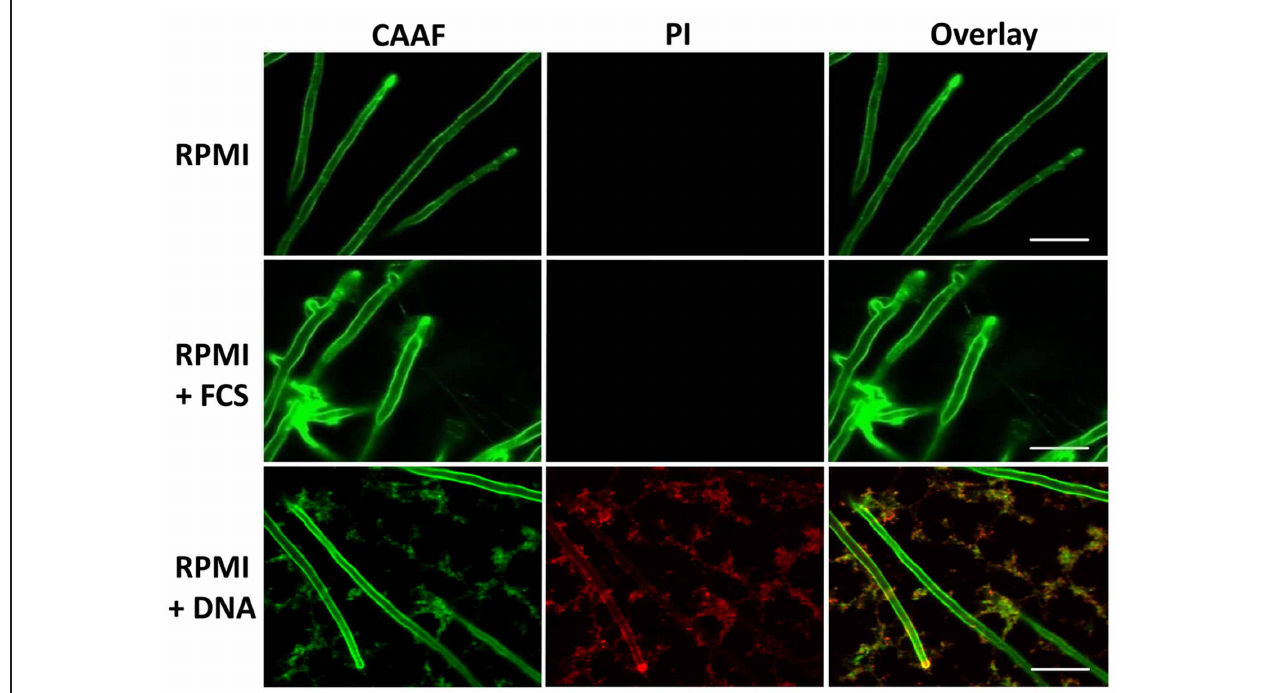
FIGURE 6 | Extrinsic DNA influences ECM distribution. Peripheries of biofilms grown with RPMI with either FCS or sDNA were imaged by CLSM displaying the tips of terminal hyphae. Note the cohesive